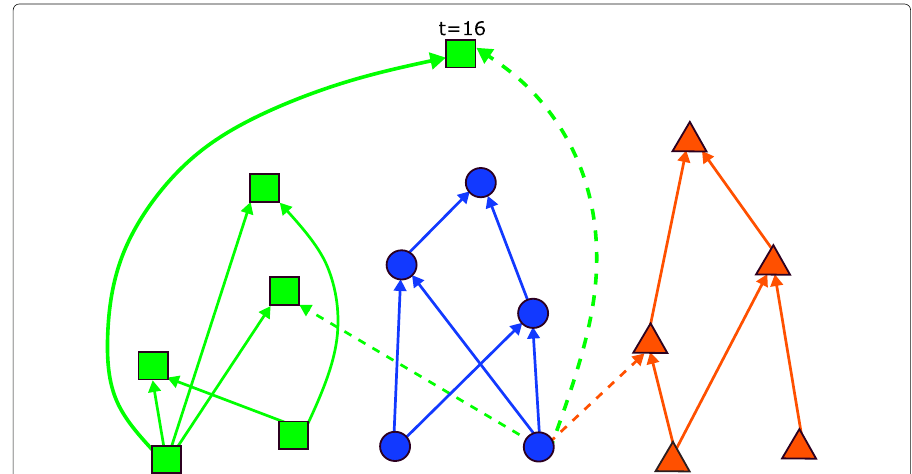
Fig. 2 An illustration of the Price model with two edges added per node ( m = 2) and three fields ( F = 3) as indicated by the three types of node. Time increases as you move up the diagram so the vertical ordering of the nodes represents a total order in the DAG. Solid (dashed) lines represent citations between papers of identical (different) fields. A new node labelled 16 = ( t + 1 ) in field 0 (green squares) is added an existing network of fifteen nodes. Here we suggest the two edges added to node 16 are to the two nodes of highest degree (the cumulative advantage bias) with one in the same field (continuous edge) and one in a different field (dashed